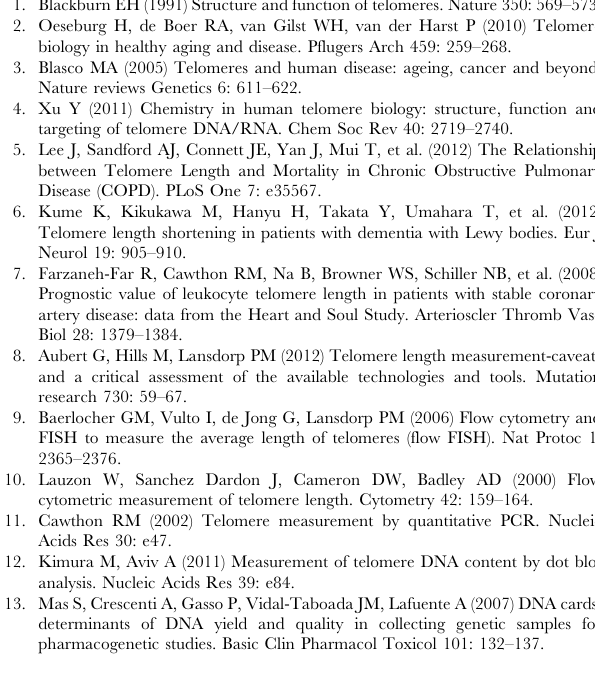
Table S1 T/S ratios for the 12 volunteers aged 23 to 50 years for blood collected from different sites with or without blotting onto paper. Table S2 Pairwise comparison of blood draw sites including p value (Wilcoxon) and common